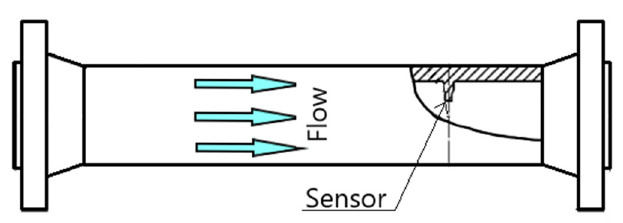
Figure 2. Full bore in line insertion Thermal Mas Flowmeter.